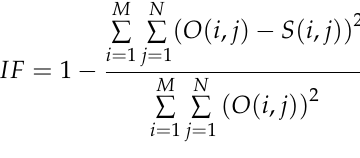
Mean Square Error: Mean Square Error (MSE) is given by Equation (4). For the two same images, the mean square error is zero. A mean square error closer to zero indicates less distortion from the cover image.